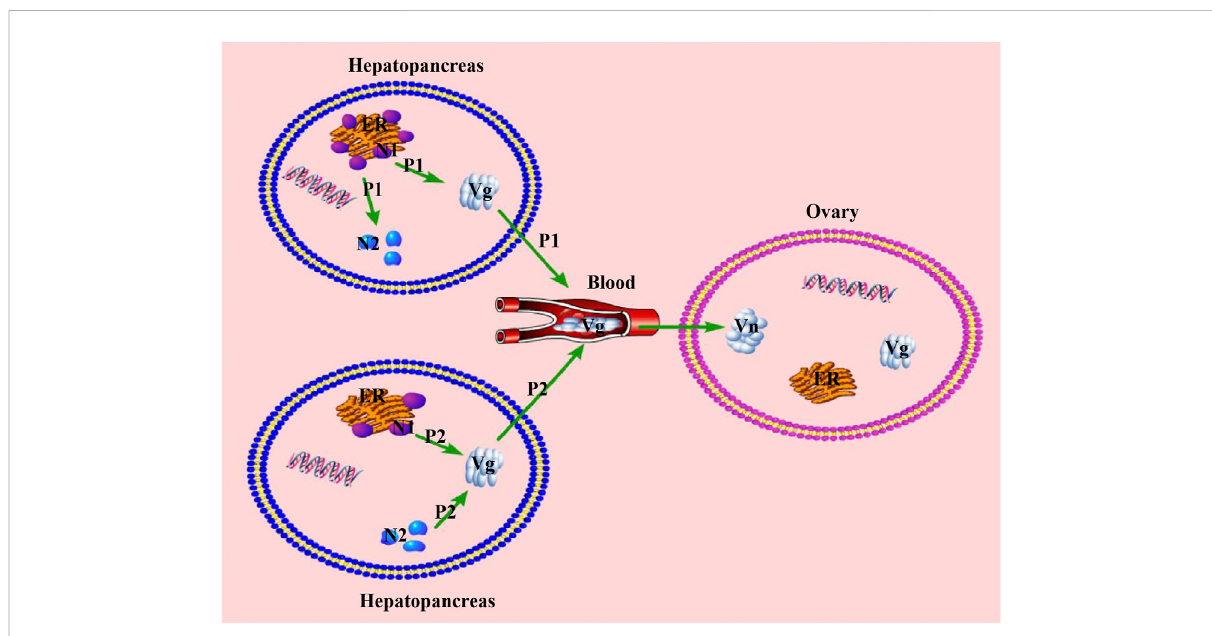
FIGURE 9 Two different patterns of nutritional transportation from hepatopancreas to the ovary during the vitellogenesis period. P1, patter one; P2, patterntwo;ER, Endoplasmic reticulum; N1,Nutrient 1,synthesized bytheendoplasmic reticulum; N2,Nutrient 2,storedinthehepatopancreas;Vg, Vitellogenin; Vn,